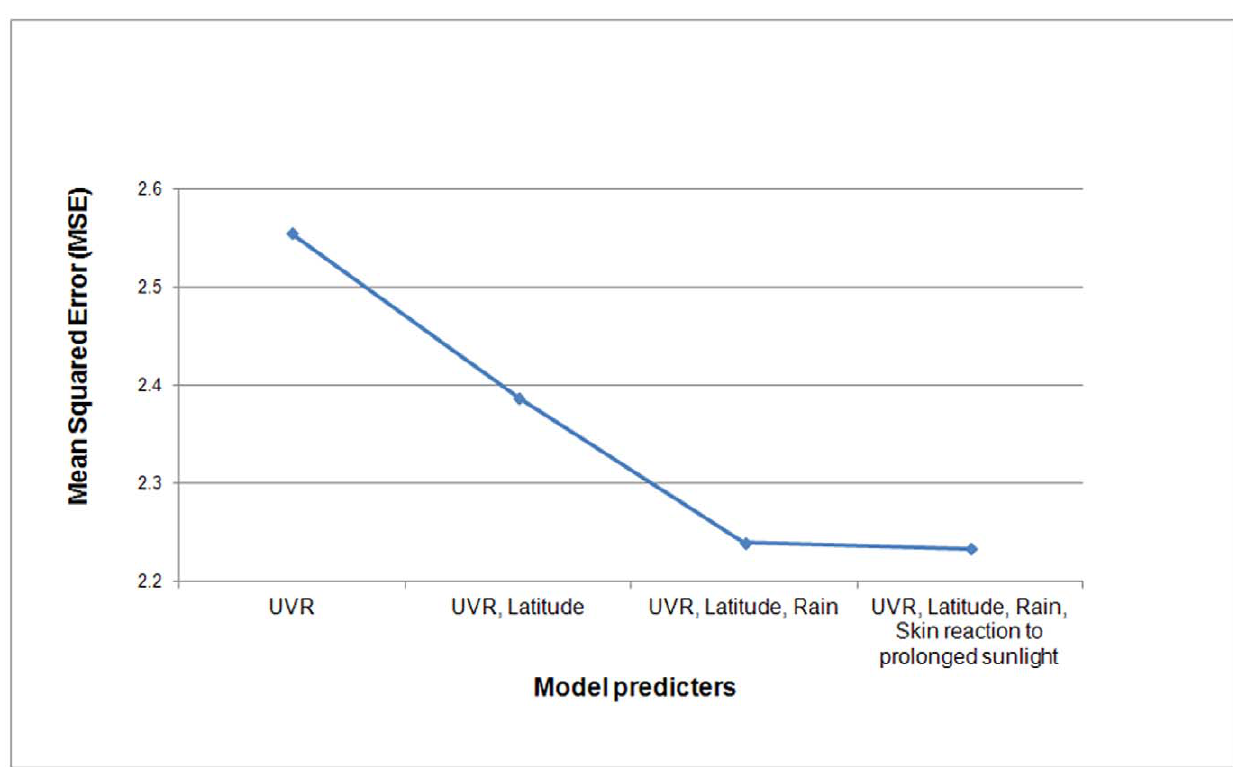
Figure 2. Cross validation of predicted vs. personal UVR dose for 4 nested models.